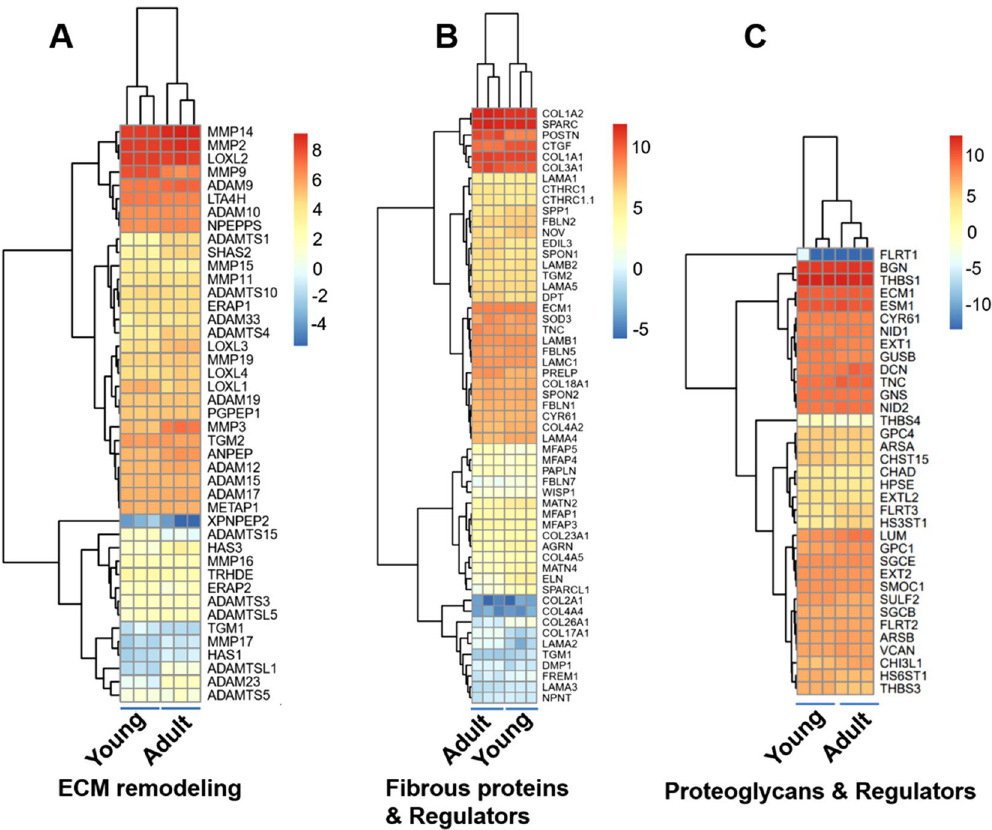
Figure 7. Heatmaps of selected gene expressions related to ECM remodeling ( A ), fibrous proteins and regulators ( B ), and proteoglycans and regulators ( C